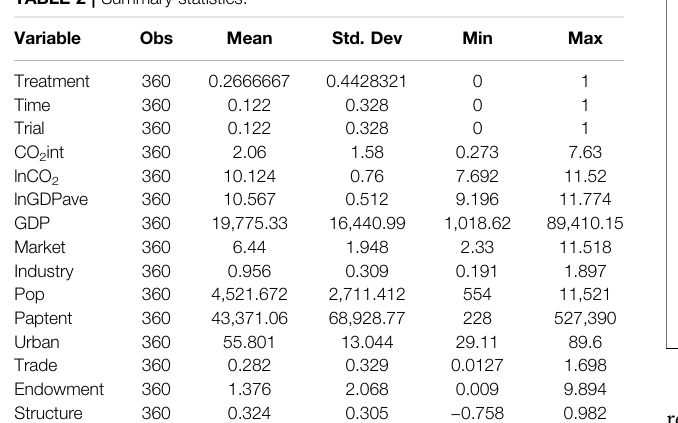
TABLE 2 | Summary statistics.